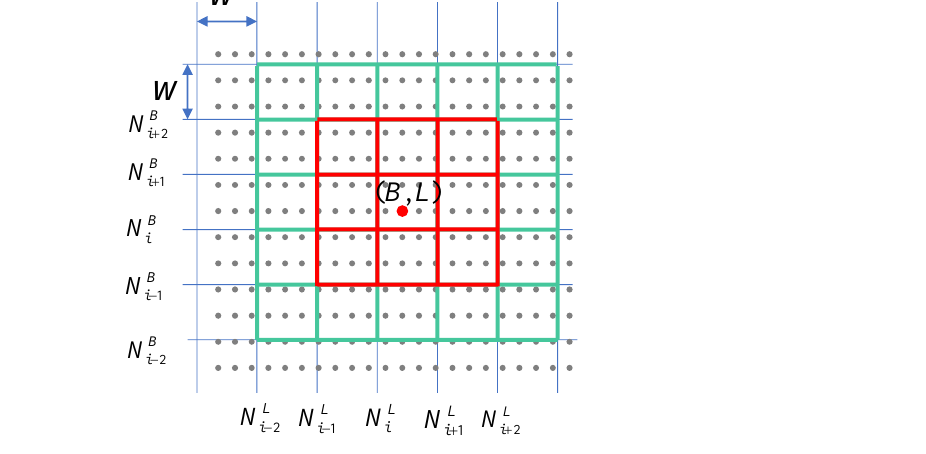
Figure 2. Quick search of local topography data based on global DEM data by reconstructing subseries boxes.